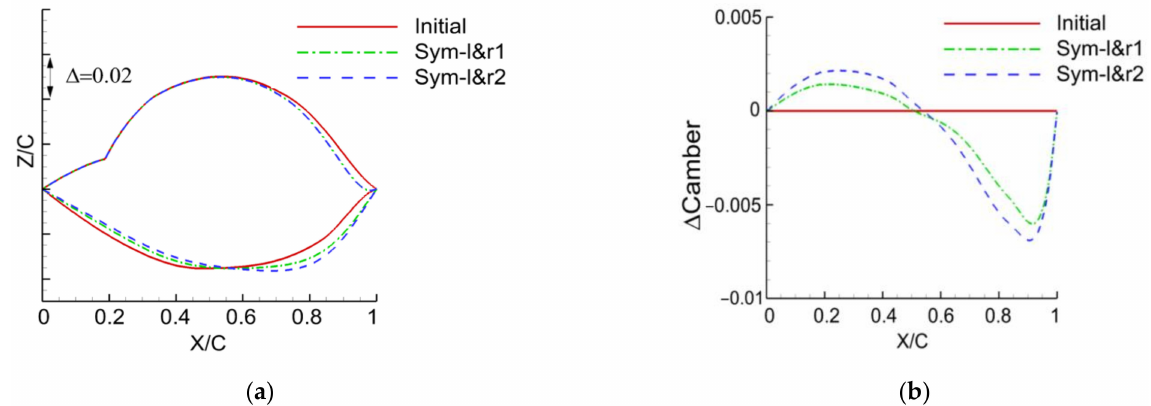
Figure 28. The fore-loading and aft-reflexing modification of symmetrical plane airfoil. ( a ) Airfoils comparison. ( b ) Camber increments